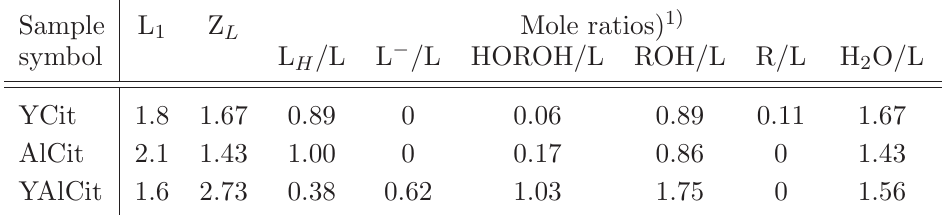
Fig. 4 SEM images of Y- (a), Al- (b) and YAl- (c) citric complexes. Table 2 Some basic characteristics of the isolated